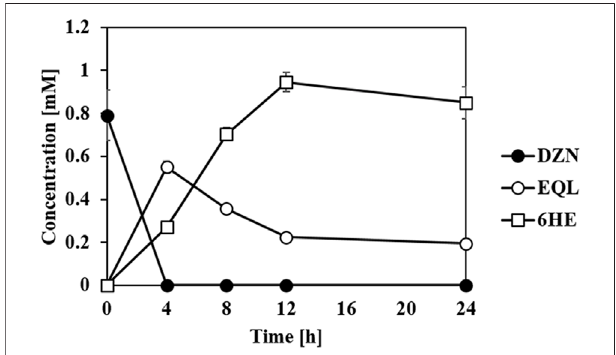
FIGURE 6 | Whole-cell biotransformation of daidzein (DZN) into ( S )- equol (EQL) and subsequently to 6HE. The tDDDT strain (previously developedbyLee et al. (2016))and t Ec HpaBC-T292A strain setupinone-pot reaction catalyzed daidzein (initial concentration: 1 mM) into equol (reduction step), and then subsequently into 6HE (oxidation step) in a highly regioselective manner. All the data were recorded using mean values with standard deviations for